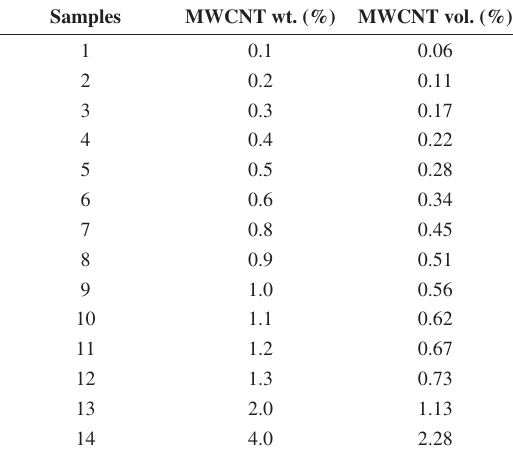
Table 1. Weight and volume loads of MWCNT in the nanocomposites of PMMA. Samples